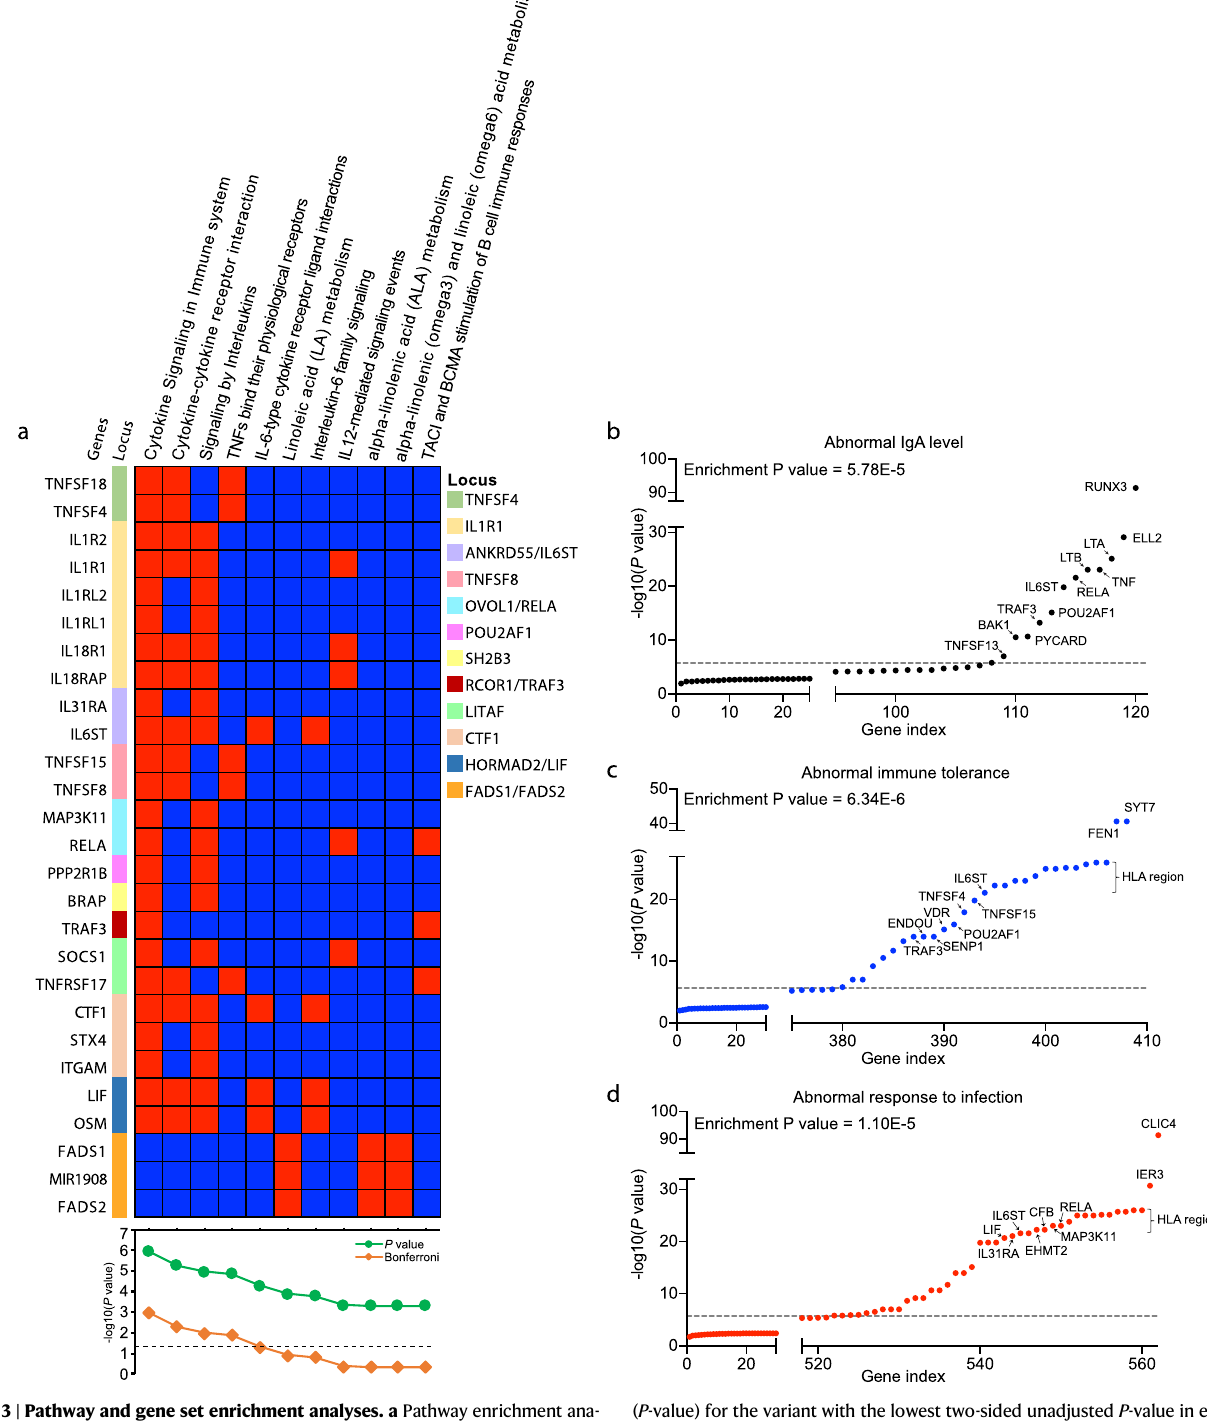
IgA levels and IgA nephropathy (inverse variance-weighted OR 9.70 per SD of exposure, 95%CI: 6.80 – 13.8, P <0.001; Fig. 5c), supporting